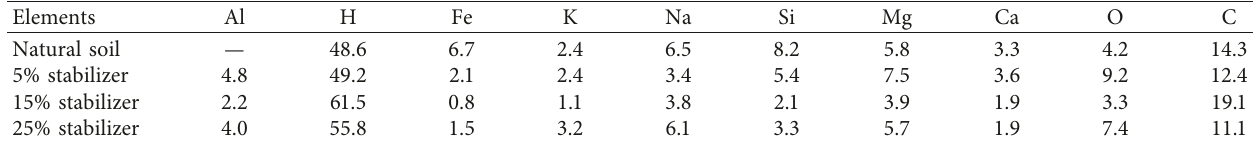
Figure 9: XRD graphs for natural soil and different mixes of stabilizers. Table 3: Percentage of elements in native and stabilized soil.